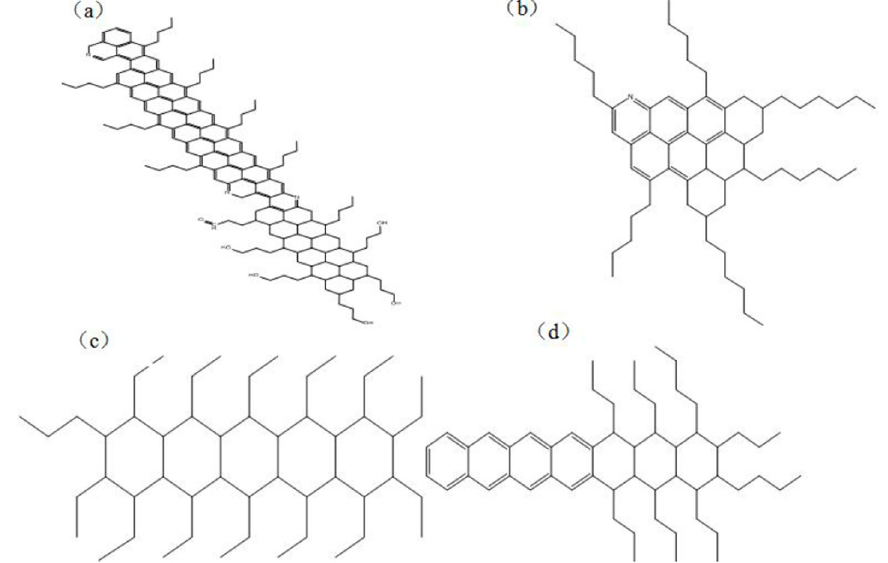
Figure 1. Components of asphalt: ( a ) asphaltenes; ( b ) resins; ( c ) saturates; ( d ) aromatics.